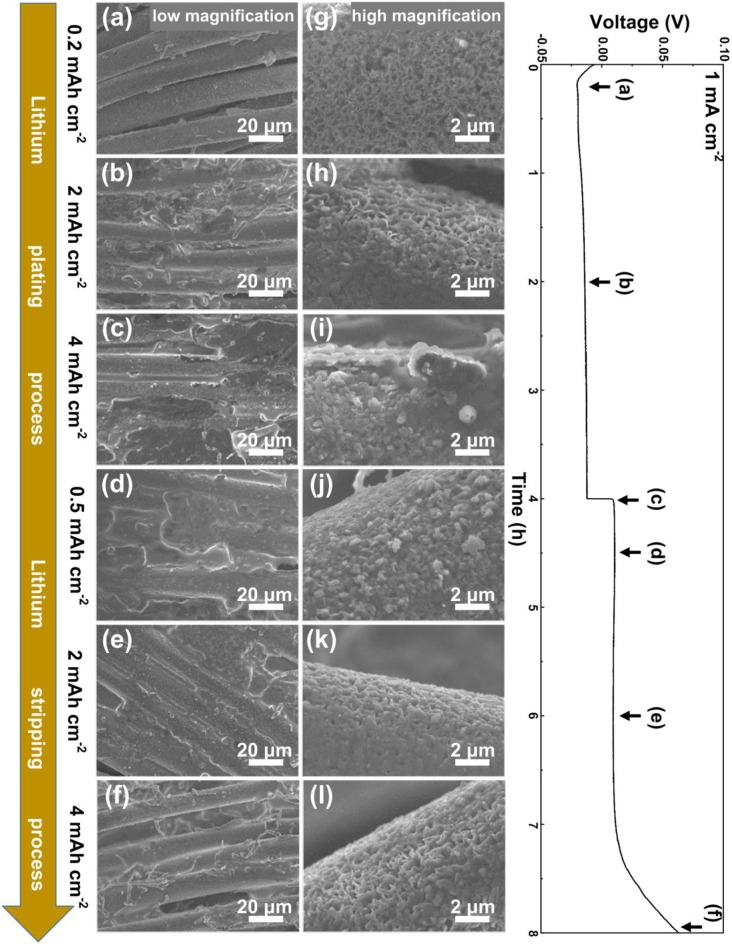
Morphological evolution of Li metal plating and stripping on VG/CC. SEM images of VG/CC electrode after being plated at a capacity of (a,g) 0.2 mAh cm−2
(b,h) 2 mAh cm−2, and (c,i) 4 mAh cm−2, and then stripped (d,j) 0.5 mAh cm−2, (e,k) 2 mAh cm−2, and (f,l) 4 mAh cm−2 at a current density of 1 mA cm−2.